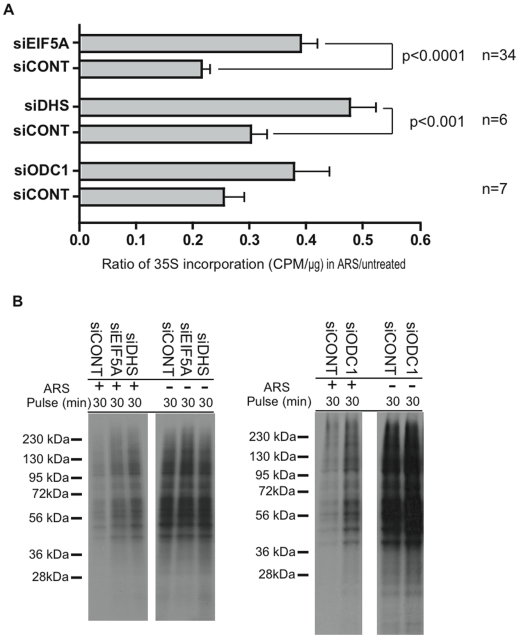
Hypusine-modified eIF5A is required for stress-induced translational arrest.(A) U2OS cells transfected with control (siCONT), DHS-specific (siDHS), or ODC1-specific (siODC1) siRNAs were cultured in the absence or presence of 0.1 mM sodium arsenite for 30 minutes, then pulsed with 35S-methionine labeling medium for an additional 30 minutes. Cells were washed and acetone precipitated to quantify 35S-methionine incorporation. The ratio of 35S-methionine incorporation (CPM/µg protein) in arsenite treated (ARS) vs. untreated cells is reported as mean ± (S.E) from the indicated number of experiments. (B) SDS-PAGE analysis of metabolically labeled protein in cell extracts with or without sodium arsenite treatment. Equivalent amounts of total protein were loaded in each lane.